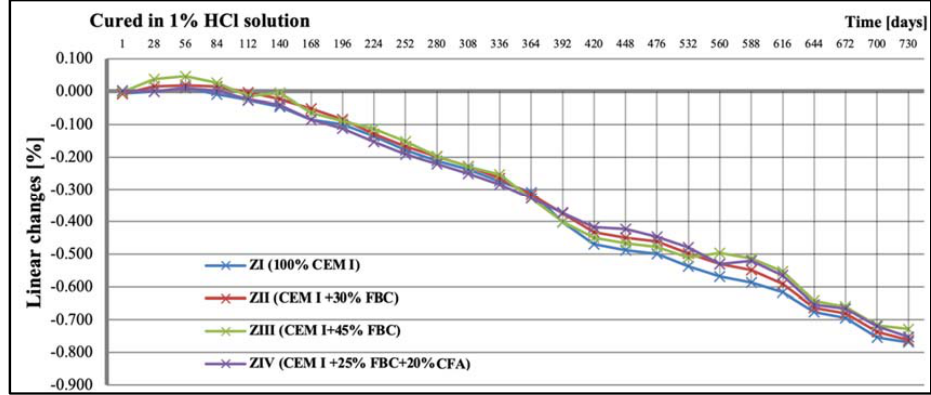
Figure 12. Linear changes of mortars cured in 1% HCl solution for 730 days. While in the 3% HCl solution, clear differences in the linear dimensions of the mor- tars were observed, depending on the quantity and type of fly ash used (Figure 13). The ZII mortar containing 30% by mass of FBC fly ash showed the greatest reduction in di- mensions in the period up to two years of testing, while the ZIII mortar with 45% by mass of FBC fly ash showed the smallest linear changes out of all mortars tested. From the 588th day of testing, a rapid reduction in size for the ZI, ZII, ZIII, and ZIV mortars was noticed. At the end of the assumed time of testing; i.e., after 730 days, linear changes of the tested mortars, expressed by reduction in dimensions, amounted to over 1% (Figure 13).